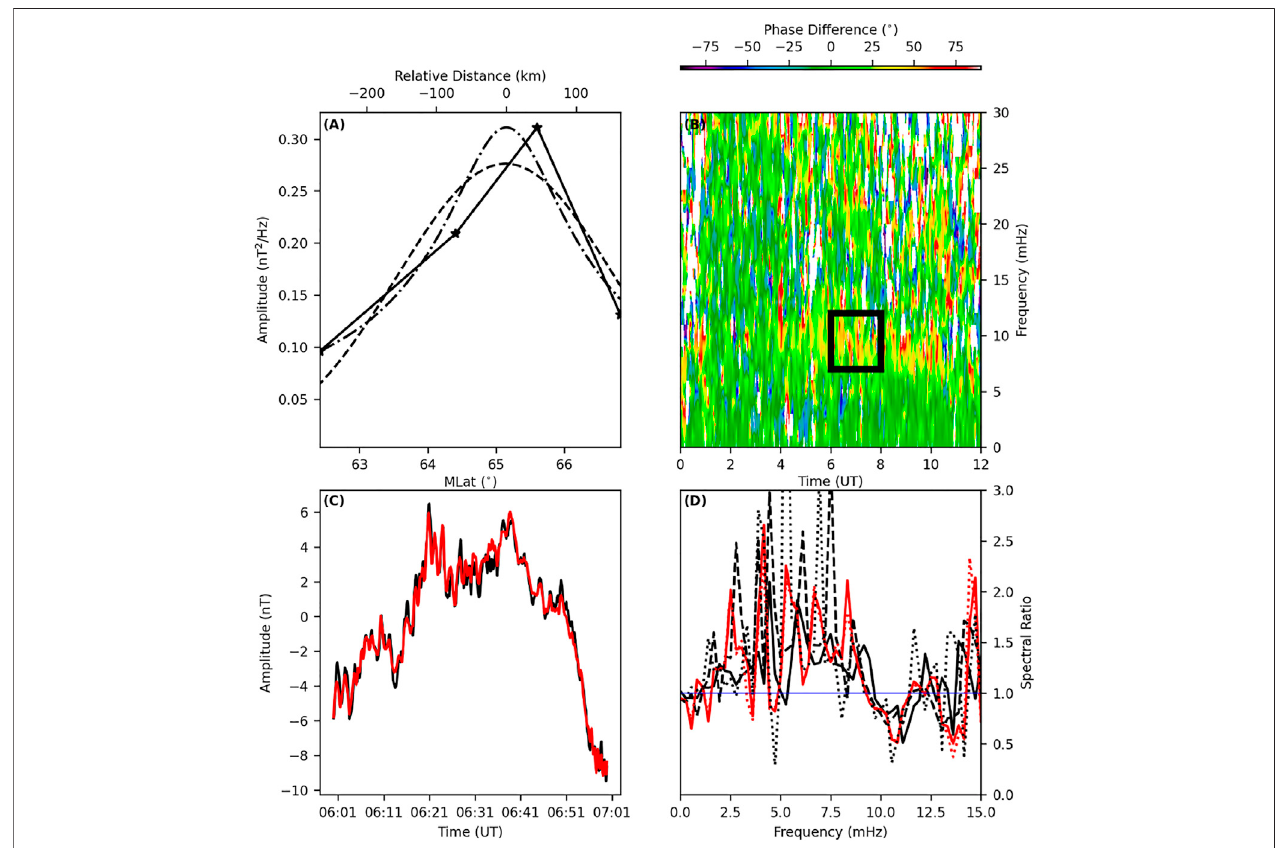
FIGURE 8 | (A) Latitudinal spectral amplitude curve fi ts; Linear piece-wise (solid, stars at station locations), Gaussian (dashed) and FLR amplitude ( Eq. 3 , dash- dotted)versusMLat/km, (B) DynamiccrossphasebetweenGIM-ISL, (C) TimeseriesoftheGIM(black)andISL(red)magnetometerstations,and (D) Spectralamplitude ratio for the boxcar (black, dotted), Hann (red, dashed), Hamming (red, solid), exponential taper (black, solid), and multi-taper (black, dashed) FFT window processing forthe GIM-ISL magnetometer data for the 25 November 2001